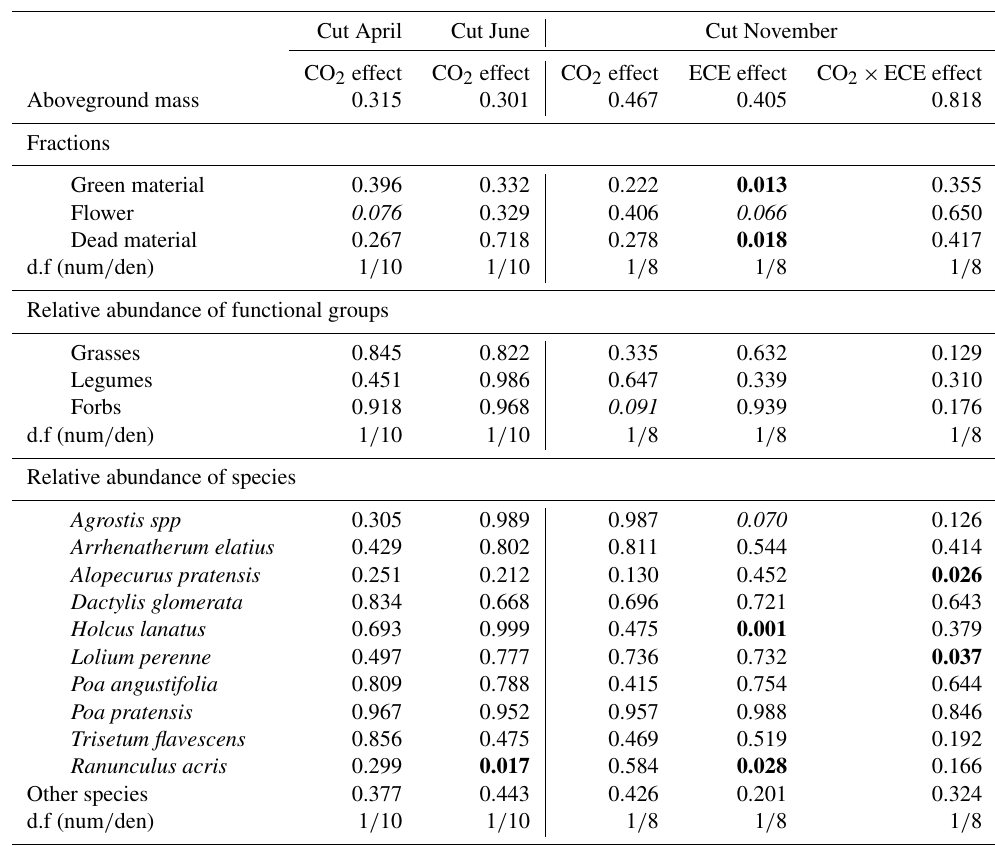
Table 2. Factor effects ( p values) on aboveground mass, fractions of green material, flower and dead material, relative abundance of functional groups, and relative abundance of the 10 most abundant species and other species ( < 15%) in plant communities exposed to two levels of CO 2 concentration (390 and 520ppm) with or without an extreme climatic event (ECE) at three different cutting